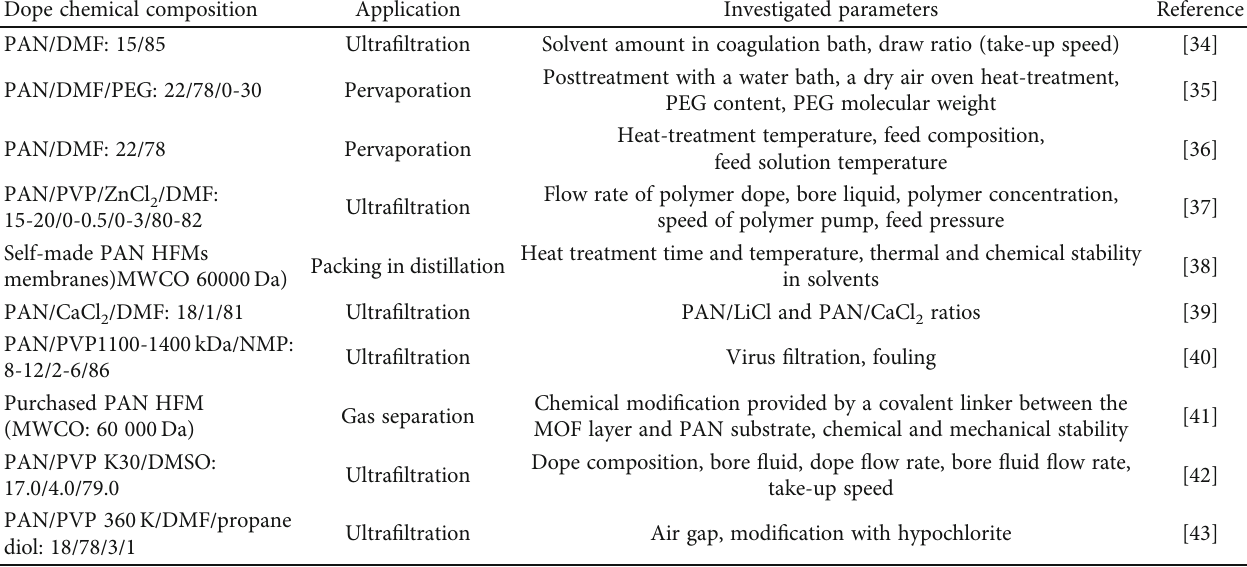
Table 1: State of the art for PAN hollow fi ber